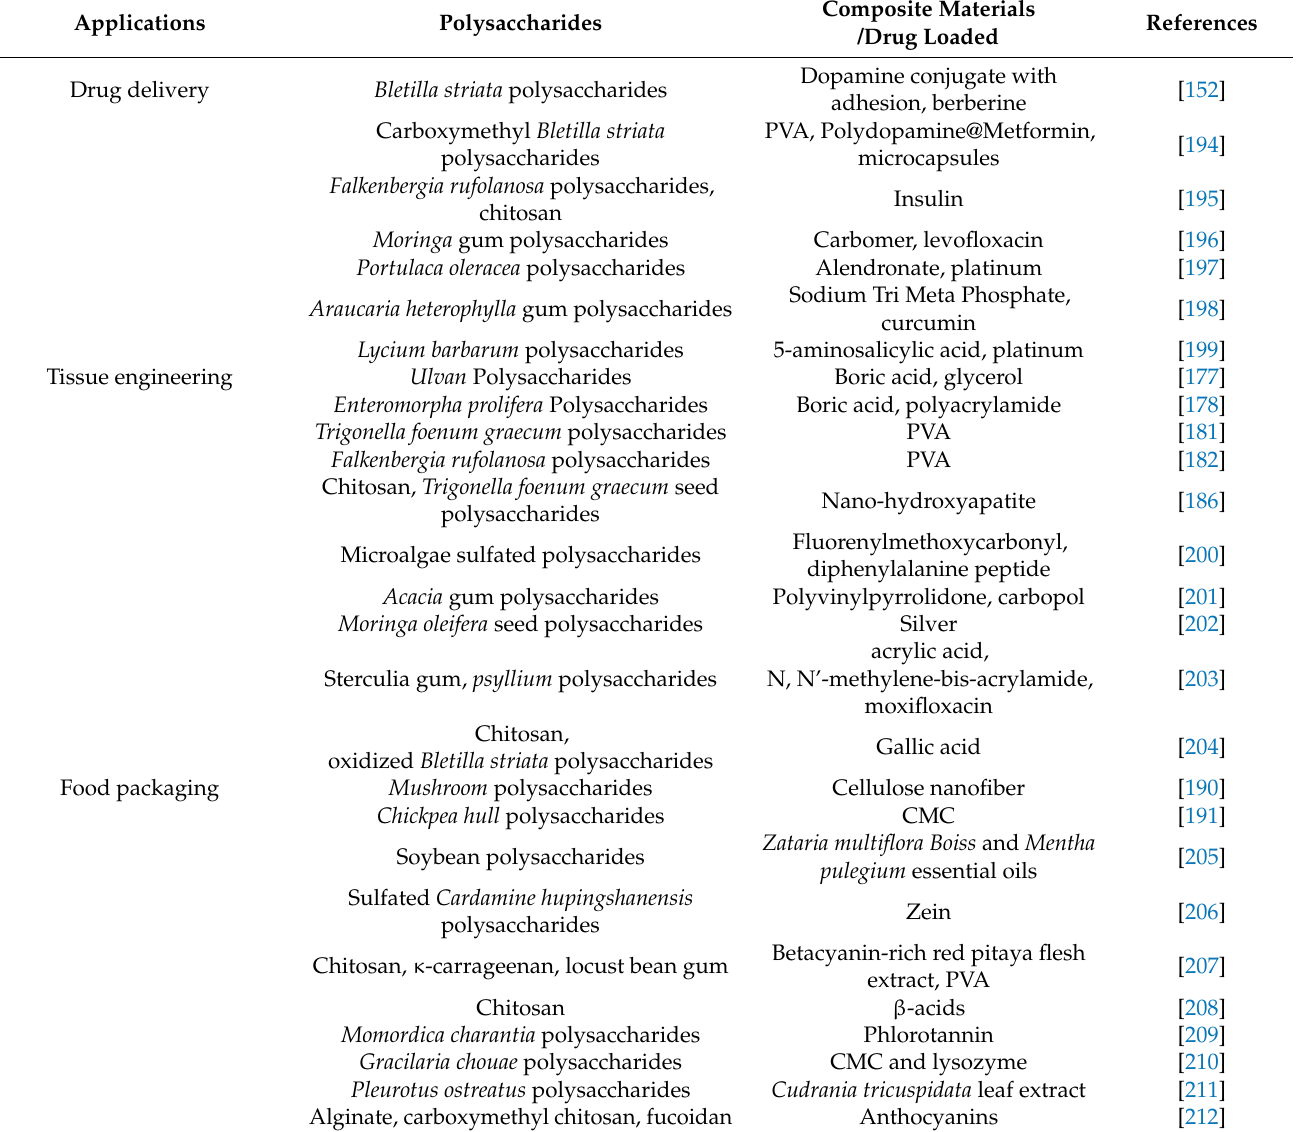
Table 2. Natural polysaccharides and their